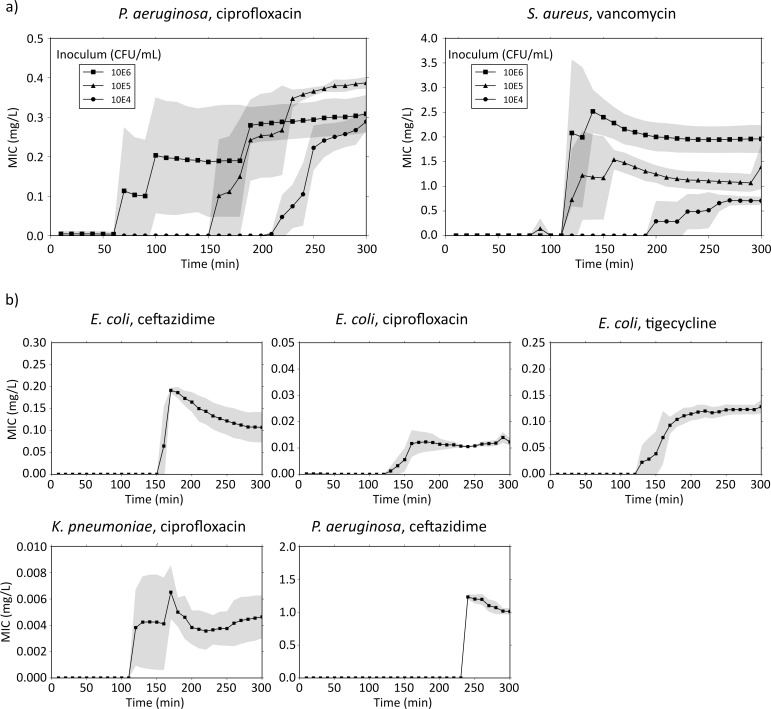
MIC over time for quality control strains.a) MIC determination and stabilisation over time for different inoculum sizes of S. aureus (VSSA) and P. aeruginosa, tested against vancomycin and ciprofloxacin, respectively. b) MIC over time for E. coli against ceftazidime, ciprofloxacin and tigecycline, K. pneumoniae against ciprofloxacin, and P. aeruginosa against ceftazidime, at an inoculum size of 105 CFU/mL. Grey fields signify standard deviation (n = 3).